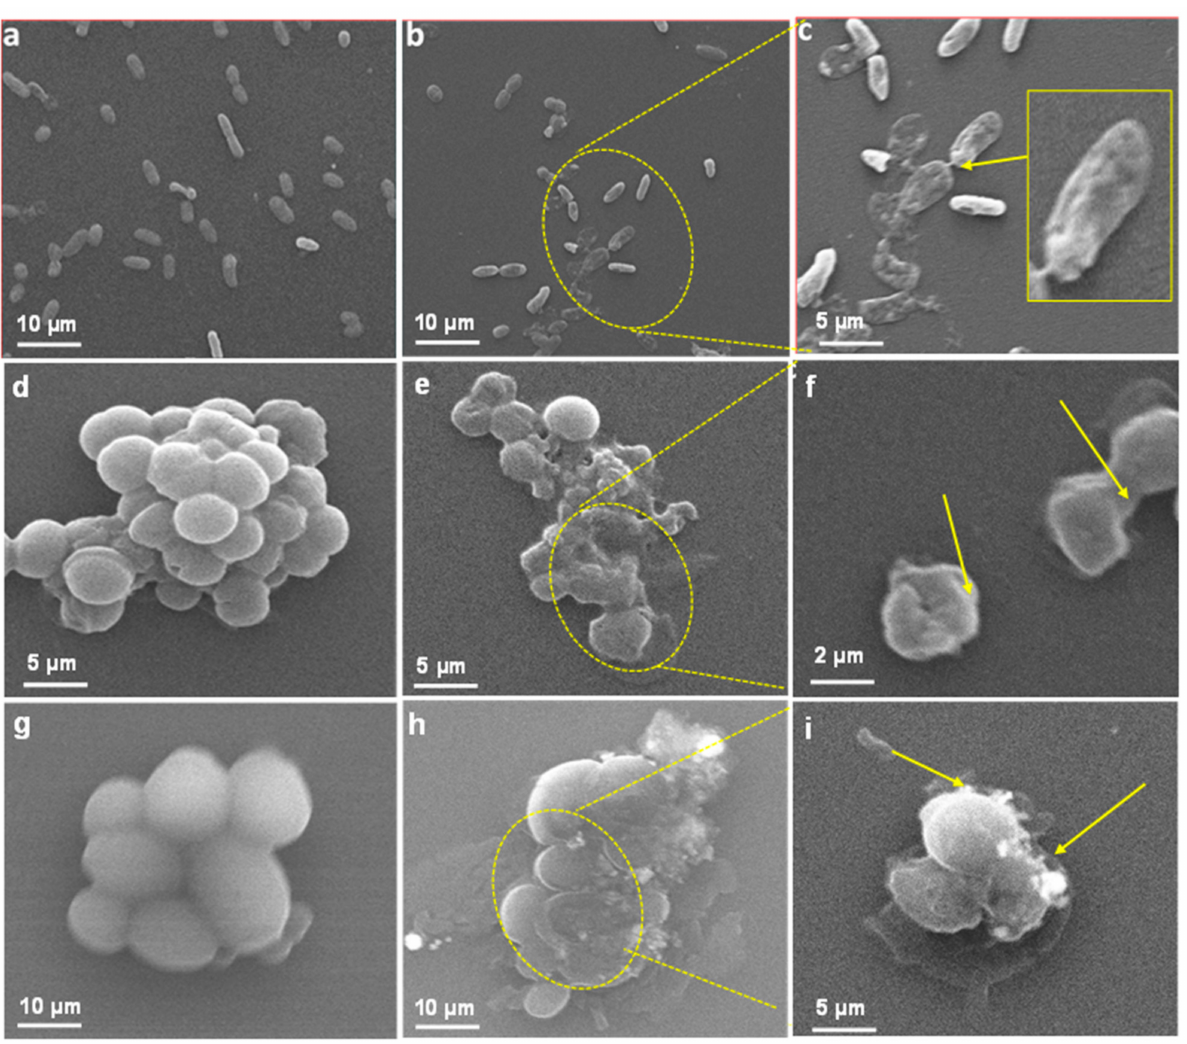
Figure 8. Interaction between LIV-AgNPs and microbial cells. Panels ( a , d , g ) represent SEM images of MDR-PA, MRSA and C. albicans cells in the absence of PLE-AgNPs. Whereas, panels ( b , c , e – i ), demonstrate cellular damage in MDR-PA, MRSA and C. albicans cells in presence of 100 µ g/mL of LIV-AgNPs at low (10–5 µ m) and high (5–2 µ m) scales,